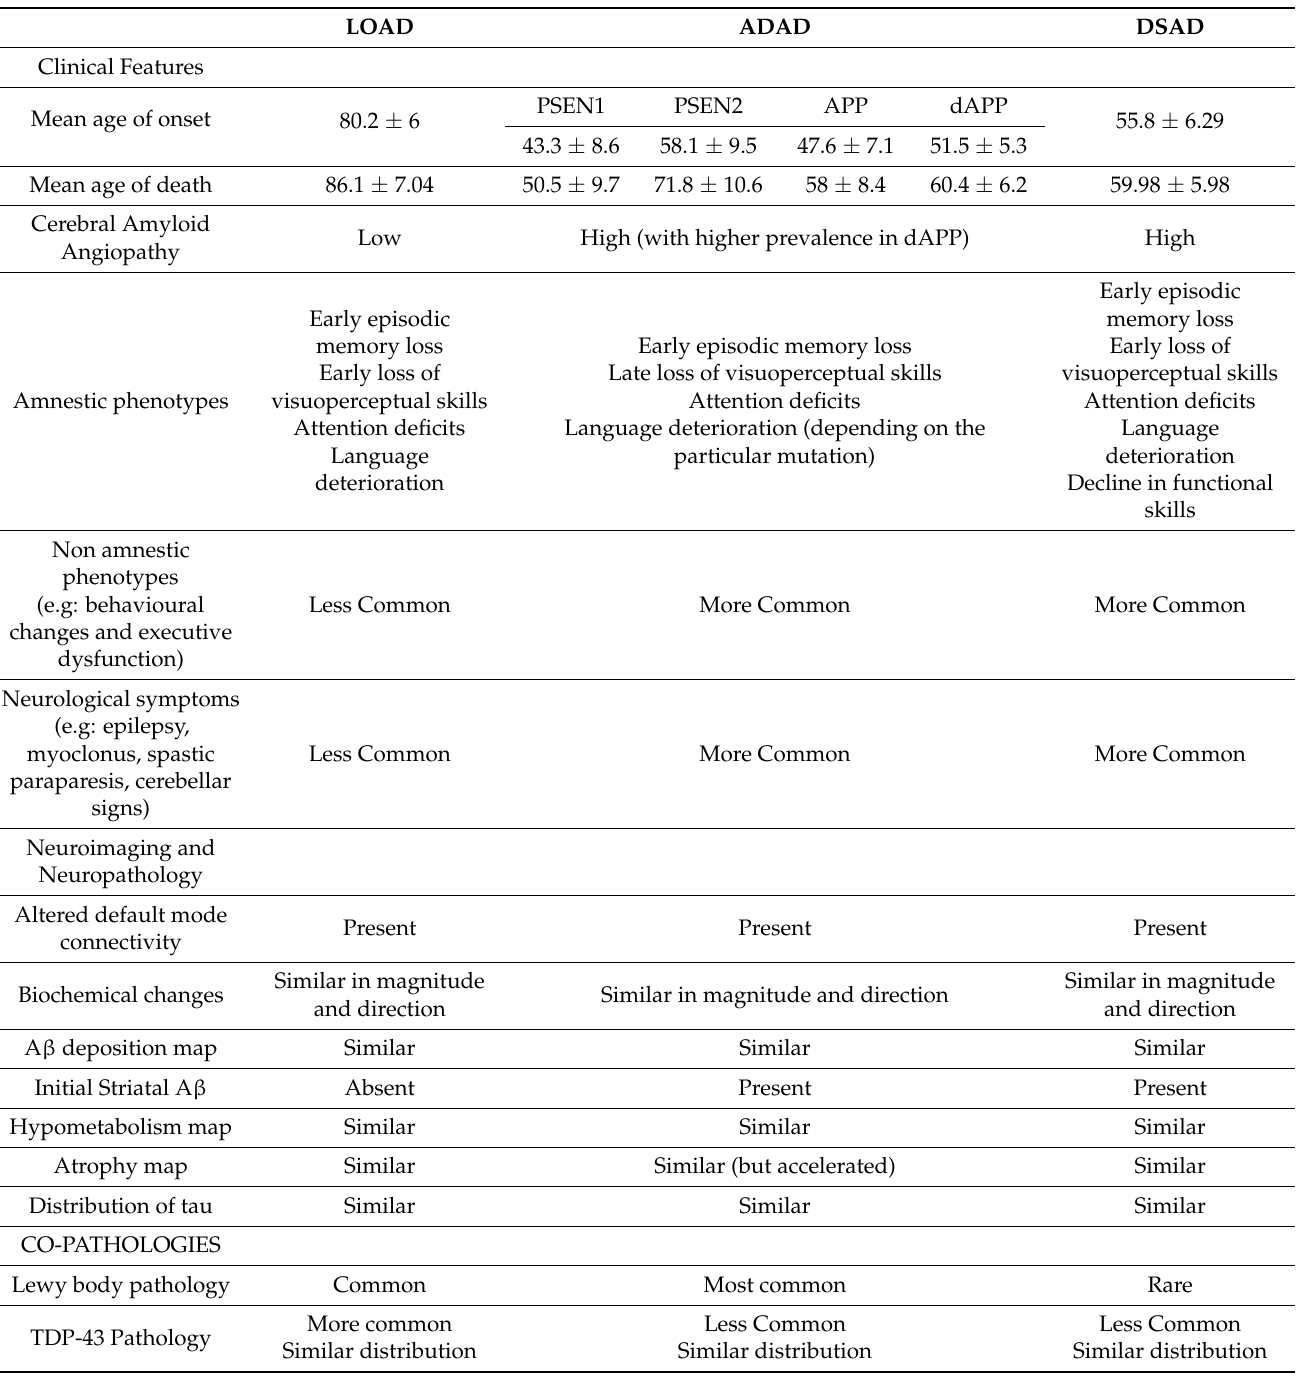
Table 1. Summary of the comparison between the three forms of